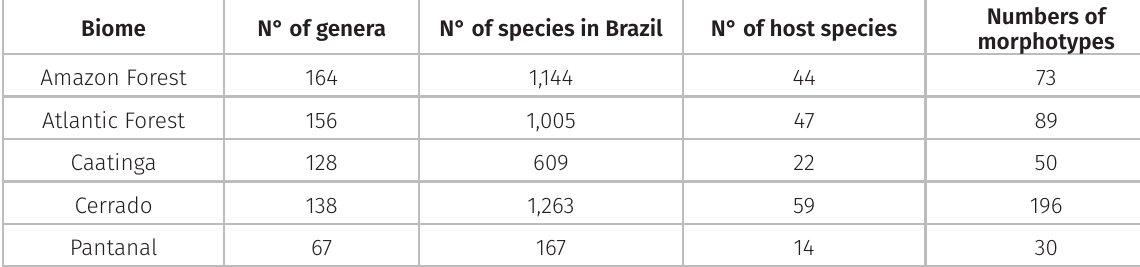
Table IV. Gall morphotypes reported in Fabaceae in Brazil. Shape Number Globoid 142 Lenticular 104 Fusiform 87 Amorphous 43 Cylindrical 21 Conical 20 Marginal roll Parenchymatous Leaf fold